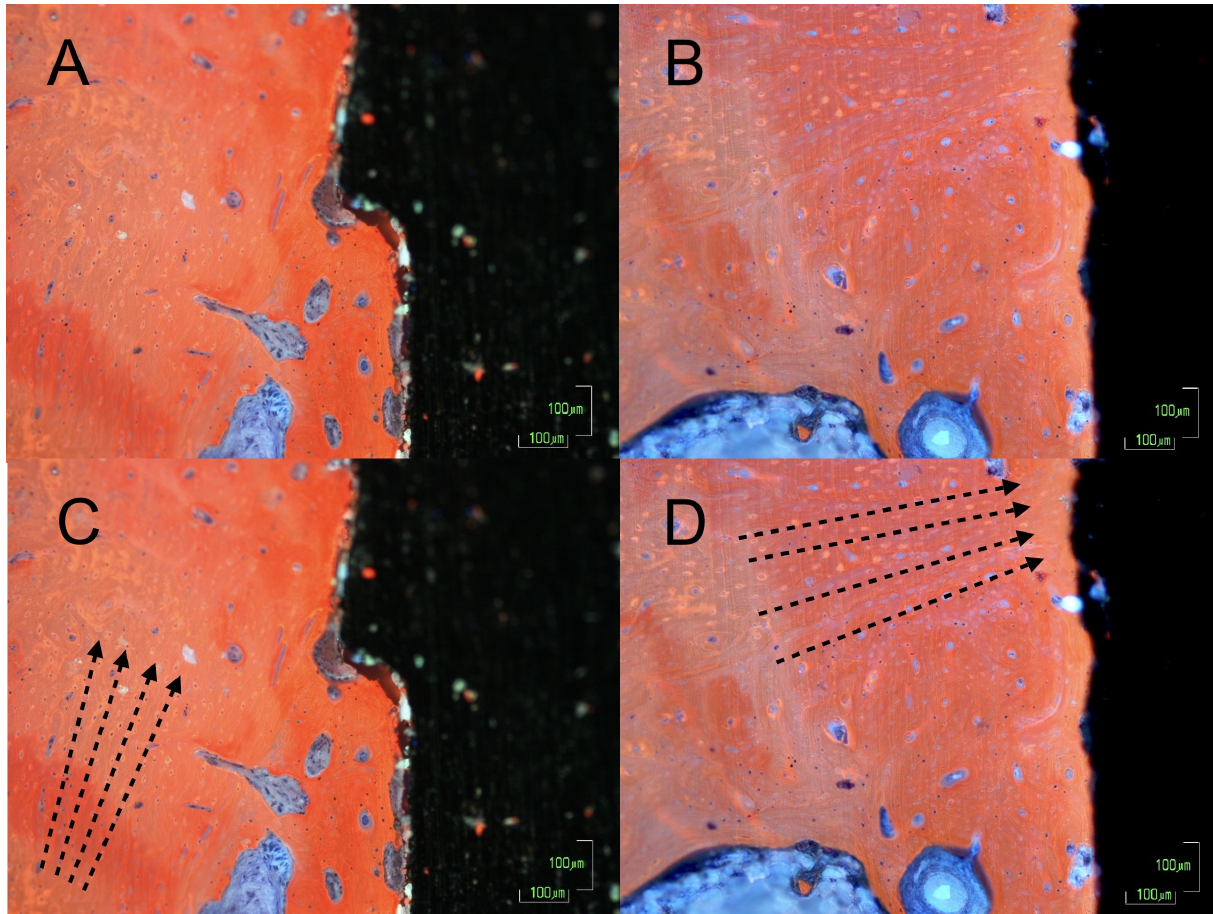
Figure 5. Optical microscopy (10 × ) image of the control ( A ) and the test ( B ). The black arrows point the parallel orientation of the matrix with respect to the implant in the control group ( C ) and the perpendicular orientation in the test group ( D